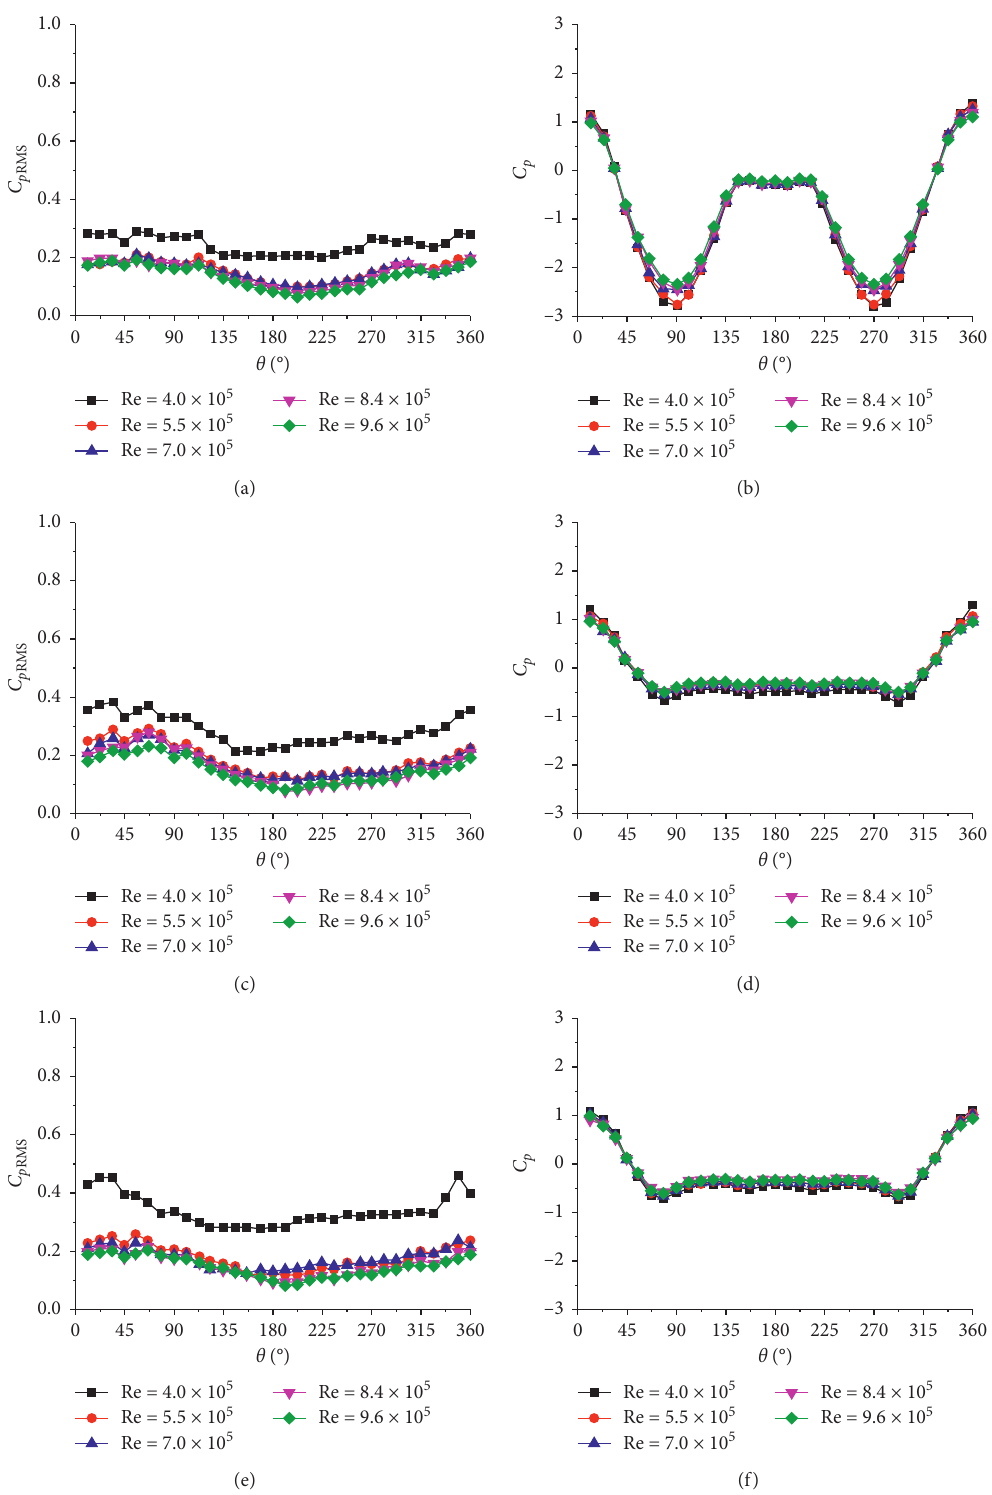
Figure 10: Effect of the Reynolds number on (a, c, e) fluctuating and (b, d, f) local mean wind pressure coefficient. (a, b) c � 0, (c, d) c � 0.0386, and (e, f) c �